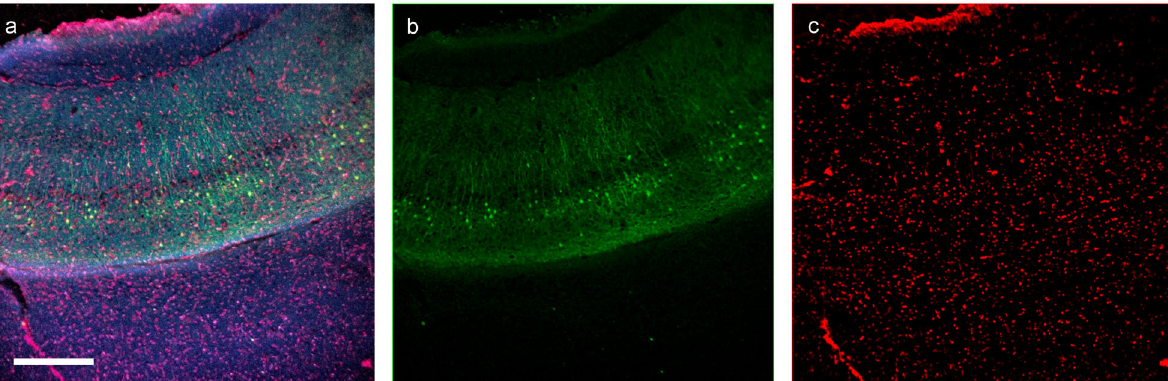
Fig. 4 IHC image of a 500 µ m thick Thy1-GFP brain slice acquired with Pocket MUSE. The sample was stained with anti-GFP antibody (Alexa Fluor 488 conjugate) and propidium iodide. a RGB image acquired with Pocket MUSE. b Alexa Fluor 488 signal (from thy1-GFP) unmixed from the green channel, showing Thy1 positive neurons. c Propidium iodide signal unmixed from the red channel of the RGB image, showing cell nuclei. Scale bar: 300 µ m.